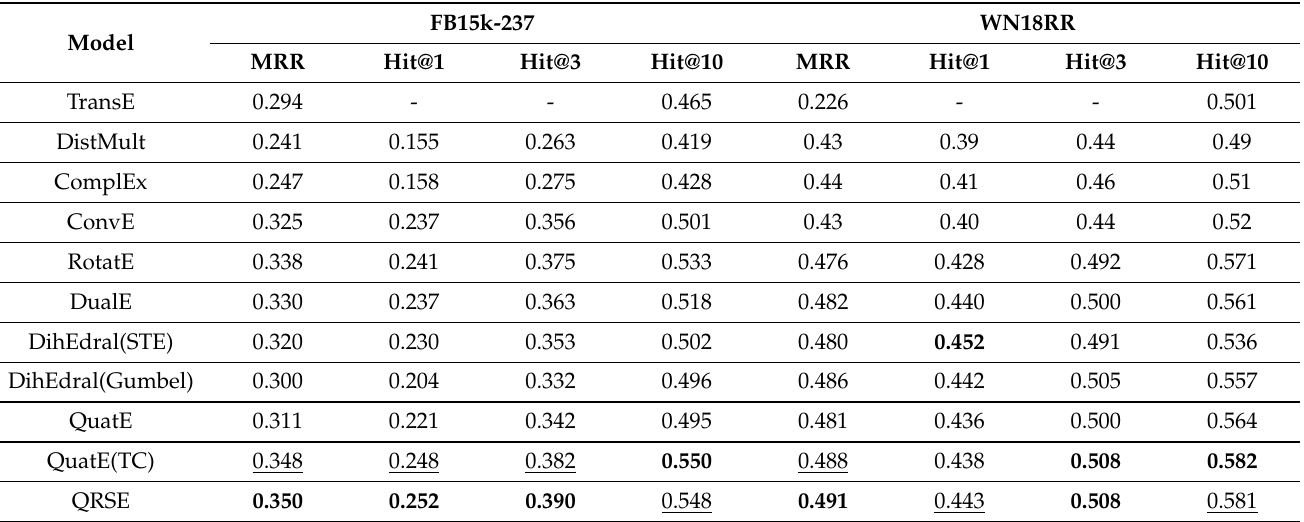
Table 4. Link prediction results on the FB15k-237 and WN18RR datasets. Numbers in boldface are the best, and underlined numbers are the second